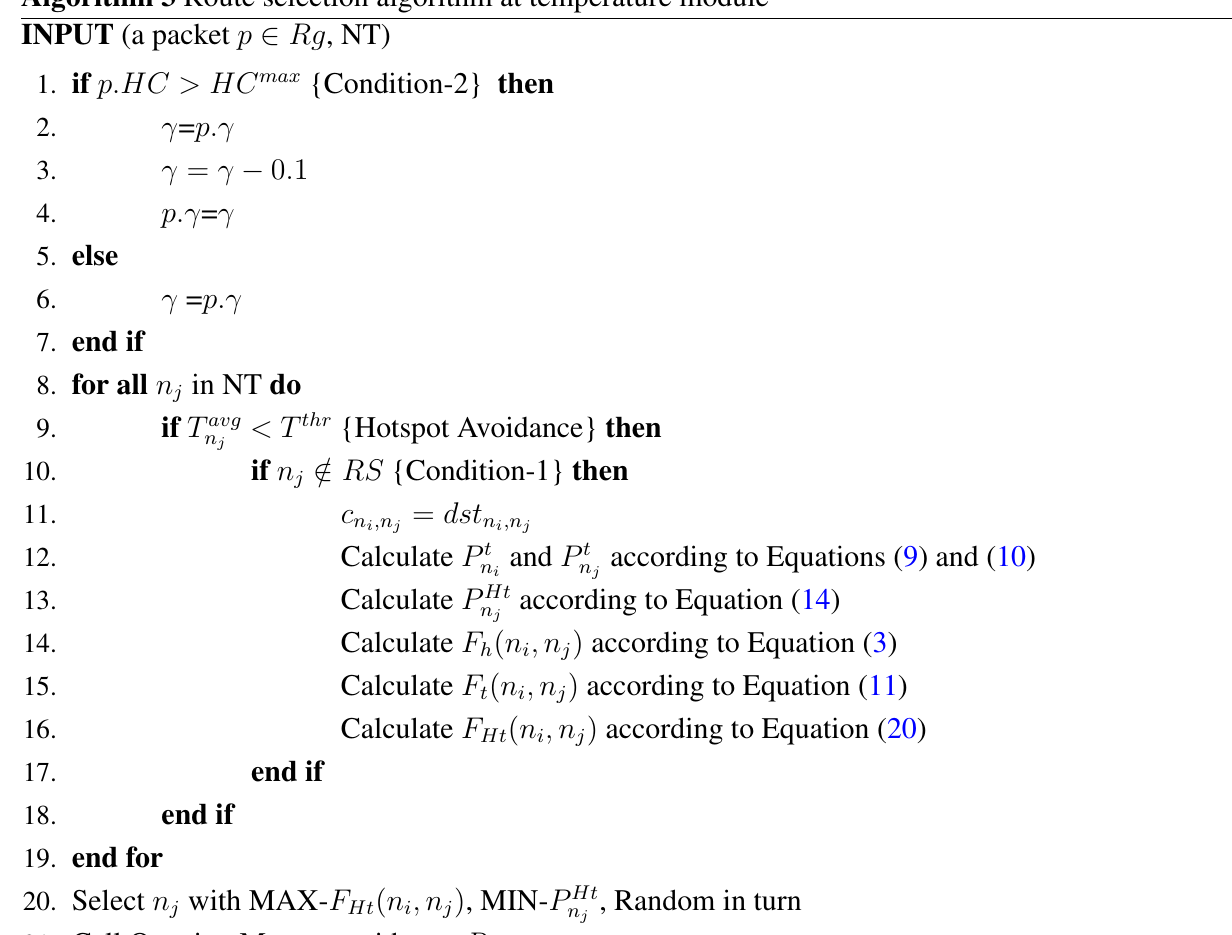
Algorithm 3 Route selection algorithm at temperature